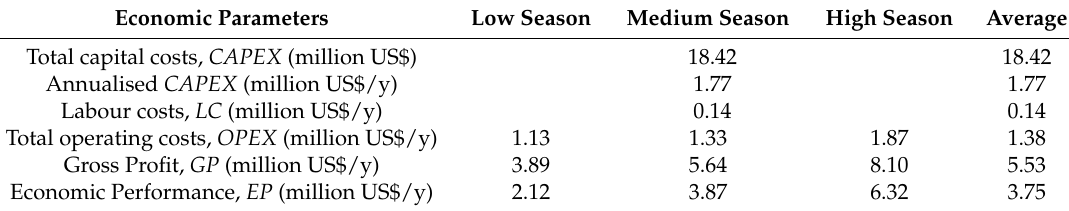
Table 2. Economic parameters for baseline POM design.